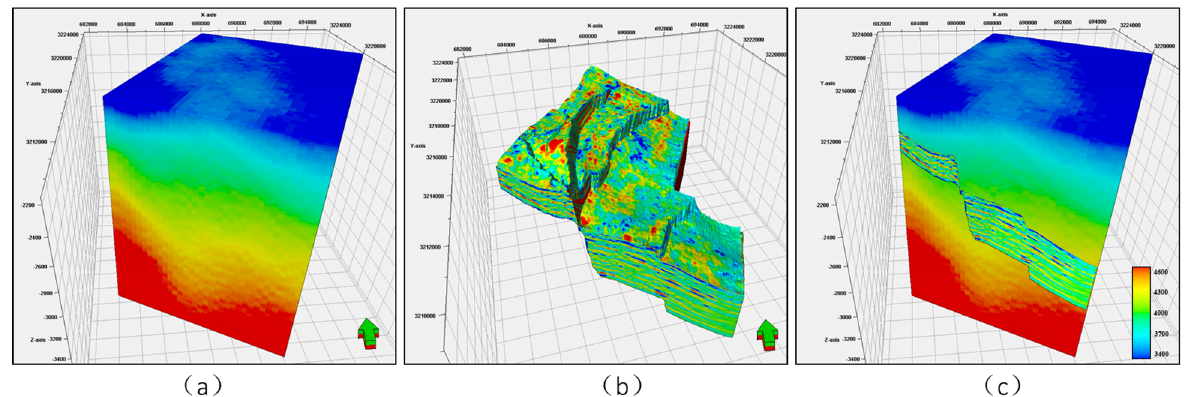
Figure 11. Velocity fields calculated by different methods. ( a ) The DIX formula calculates layer velocity. ( b ) P-wave velocity obtained from pre-stack inversion. ( c ) Velocity field obtained by attribute fusion.